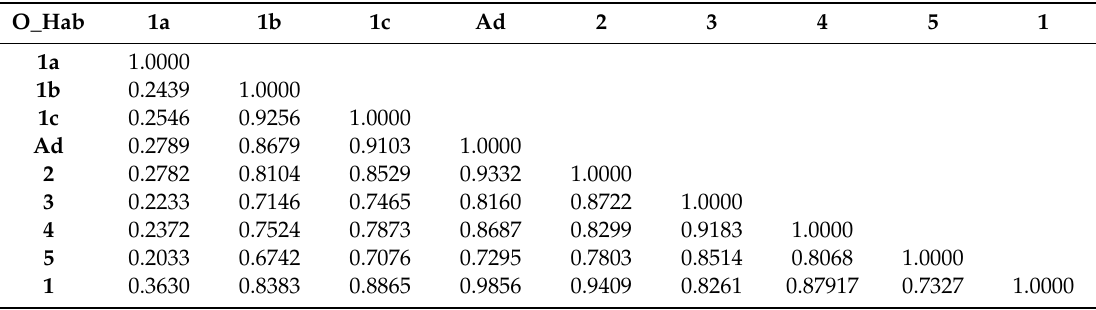
Table 3. Molecular quantum similarity indices using the overlap operator according to Equation (5).